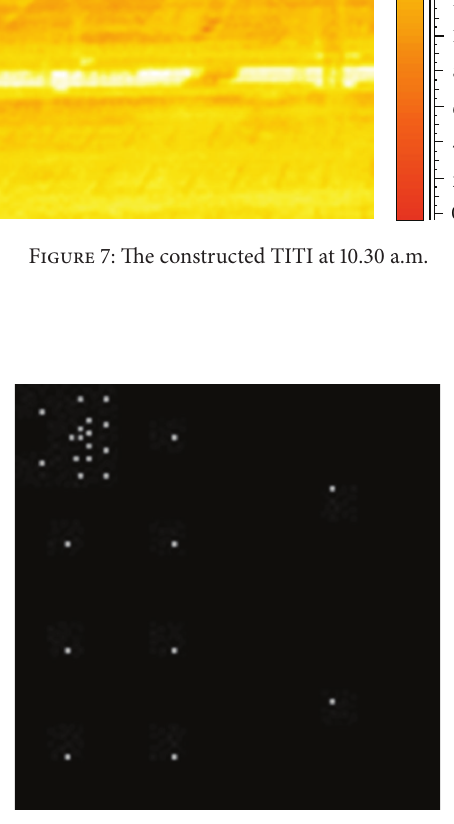
Figure 8: The eigenpoint distribution obtained from Figure 6 using the proposed method.